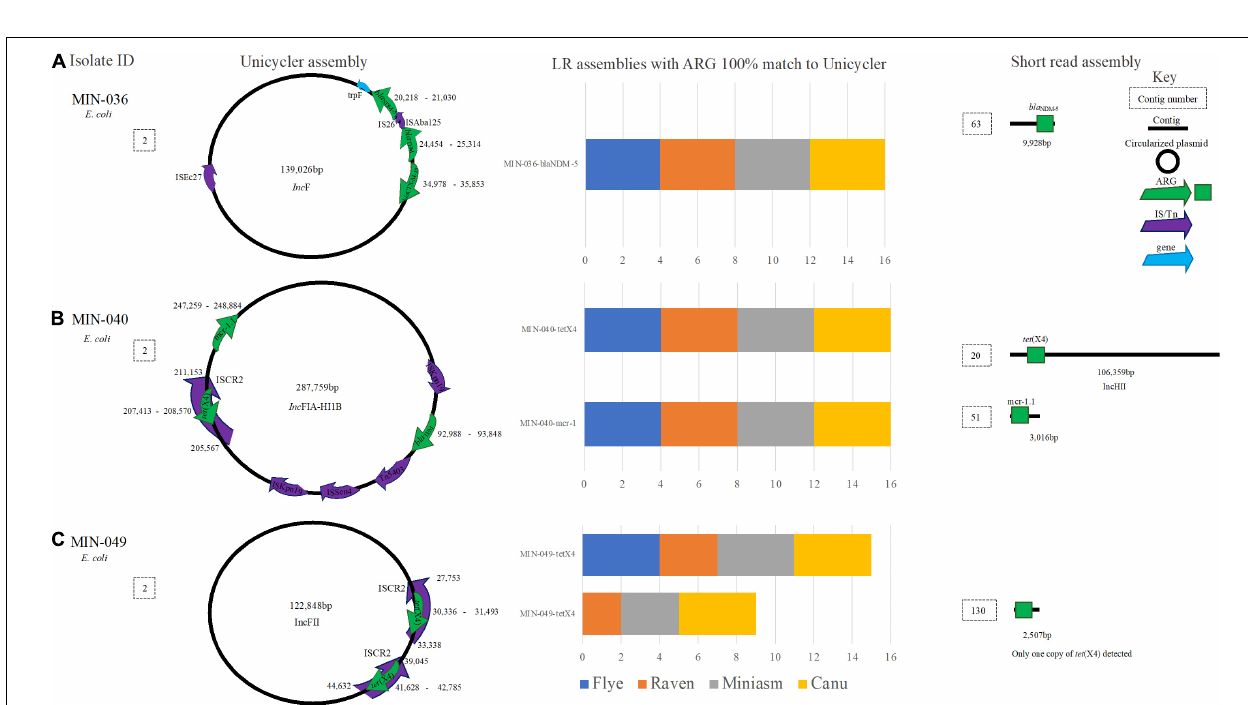
FIGURE 6 | A schematic to compare Klebsiella ARG detection from the Unicycler (hybrid) assembly (left), with the short read (SR) assembly (right). The stacked bar graphs (center) denote the number of LR assemblies with a 100% match to the Unicycler assembly. (A) MIN-106 with bla NDM − 5 , bla OXA − 48 like on the same plasmid, (B) MIN-119 with two plasmid both containing bla NDM − 1 and (C) MIN-129, a K. quaispneumoniae isolate containing bla KPC − 2 .